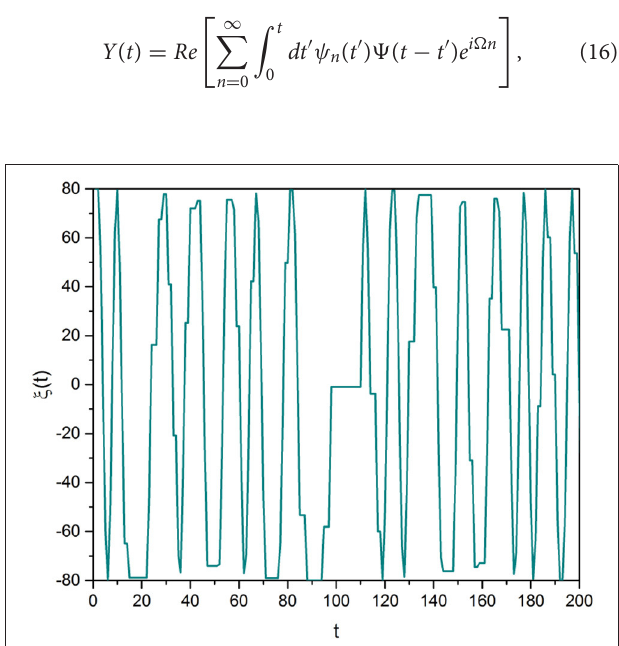
FIGURE 1 | Subordinated cosine wave with (cid:127) = 0.8 and µ =